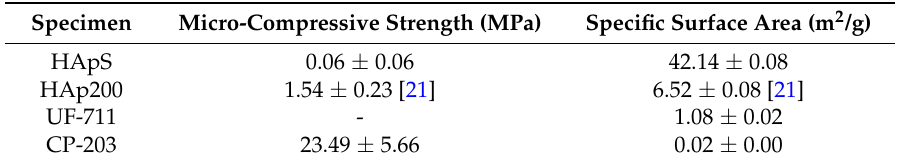
Table 3. The micro-compressive strengths and specific surface areas of the four particulate additives.